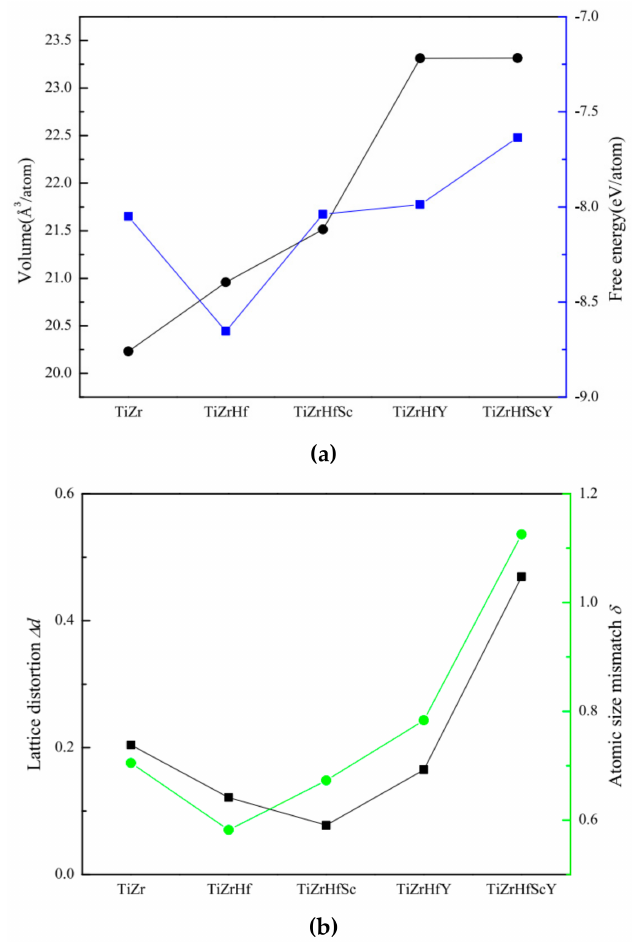
Figure 3. ( a ) Volume and free energy and ( b ) lattice distortion and atomic size mismatch of the TiZr-based